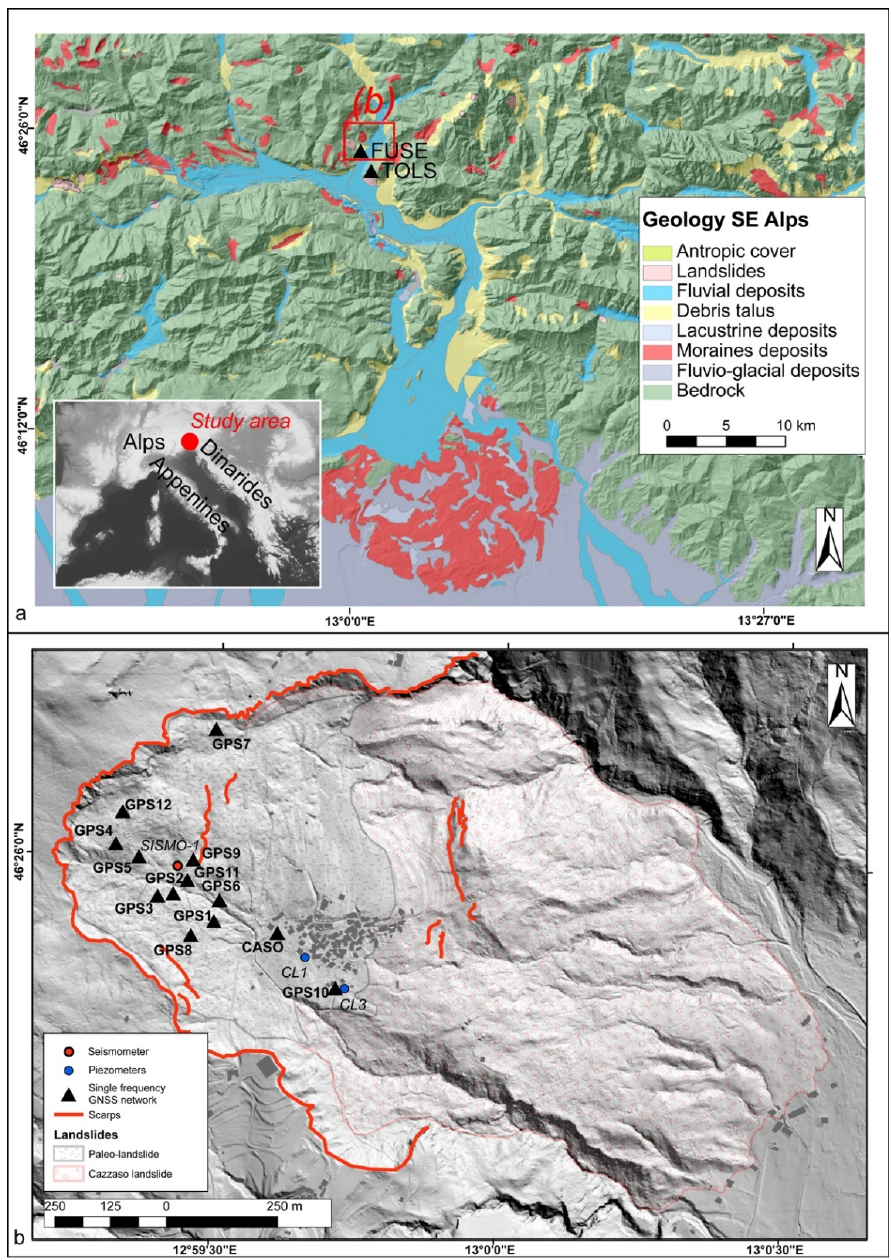
Figure 1. ( a ) Geological setting of the study area, located in the SE Alps, where there are large